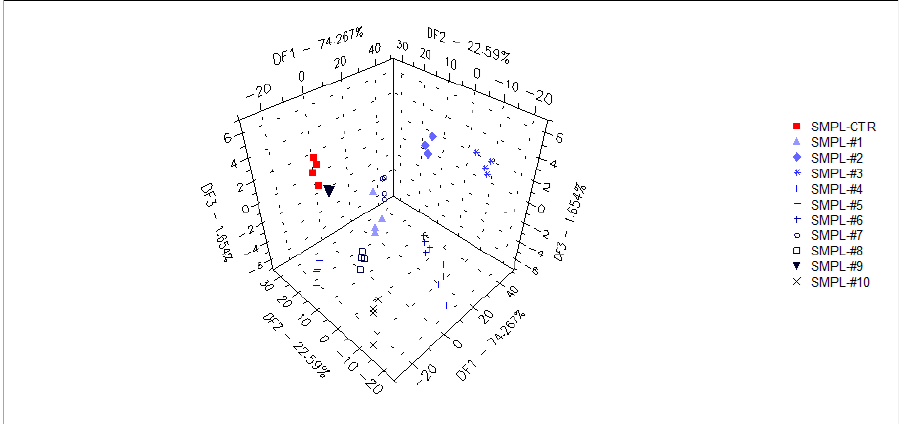
Figure 7. 3D plot of the DFA classification of samples with different S17-P100 inclusion levels based on the data of the selected qualitative sensors (cross-validation score = 98%) SMPL-CTR: milkshake with no supplementation (control); SMPL#1 to SMPL#10: milkshakes with increasing levels of DHA supplementation (0.2%–2%).